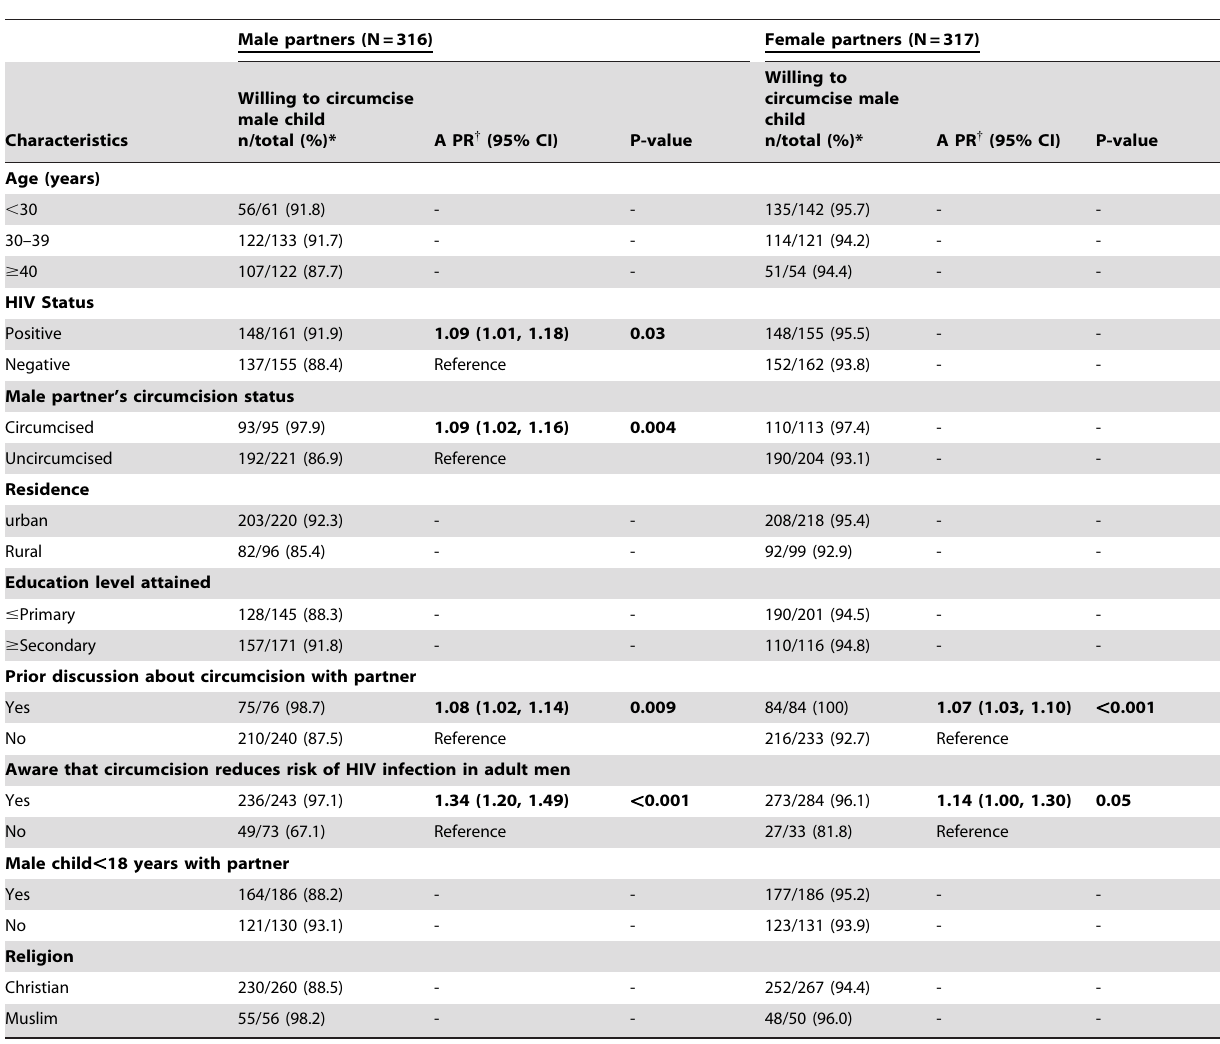
Table 1. Correlates of willingness to circumcise male children for reduction of future risk for